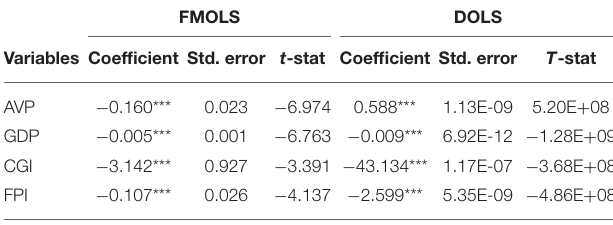
TABLE 5 | Cross-sectional dependence and CIPS unit root test results. Variables